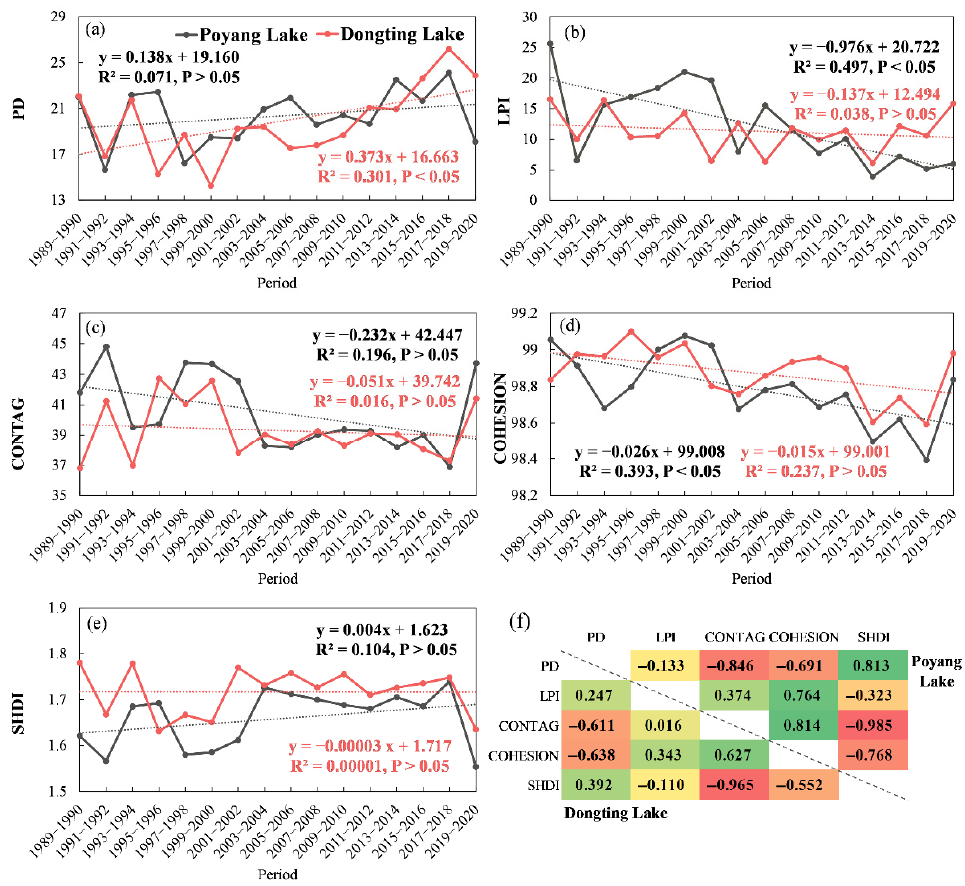
Figure 7. Time series and correlation coefficients of landscape indices in Poyang Lake and Dongting Lake from 1989 to 2020. ( a – e ) indicate the time series. ( f ) indicates the correlation coefficient.